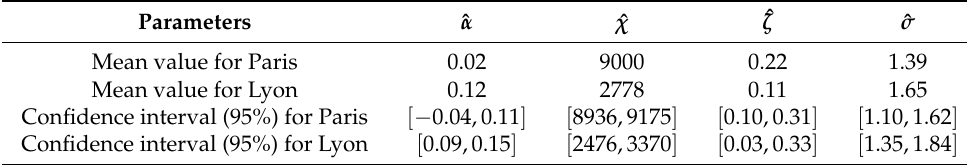
Table 3. Model parameter estimations: mean values and 95% confidence intervals obtained by bootstrap for Paris and Lyon metropolitan areas. The number of bootstrap samples is 6000. Parameters